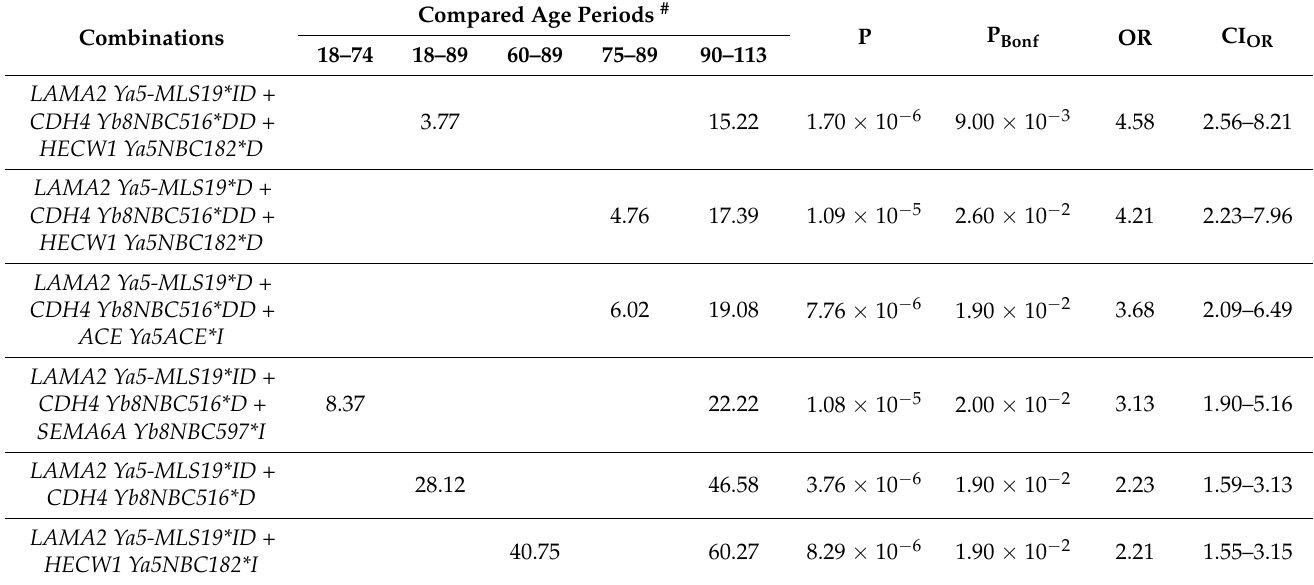
Table 3. Allelic/genotype combinations most significantly associated with longevity according to APSampler